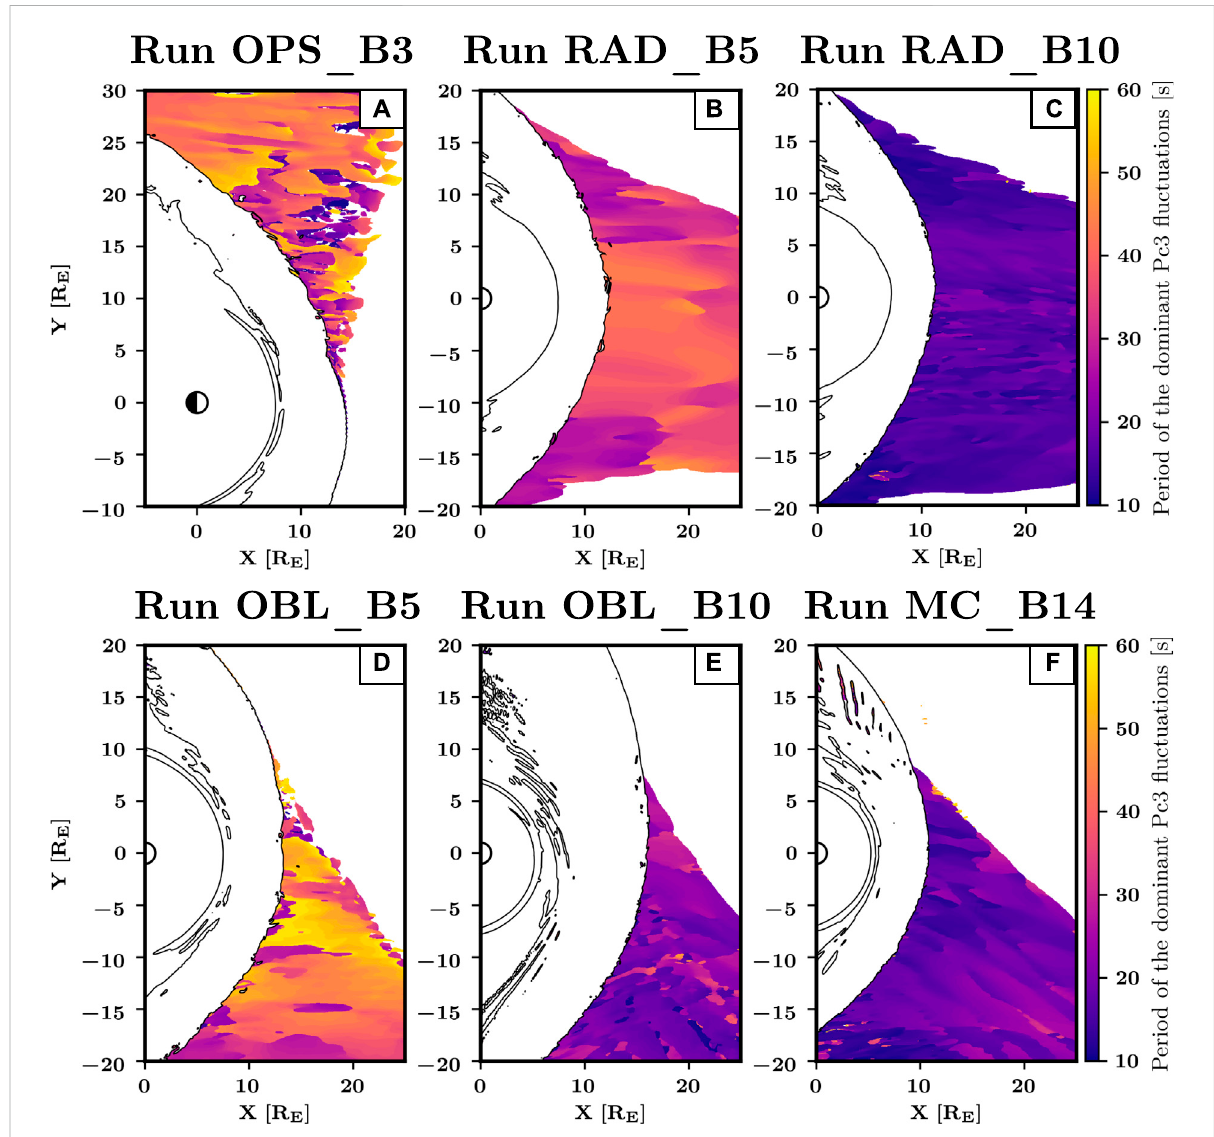
FIGURE 2 Period of the dominant B z fl uctuations upstream of the bow shock in the different runs. The black contours are plotted where n = 2 n SW . The sunwardmost black contour in each panel corresponds to the bow shock